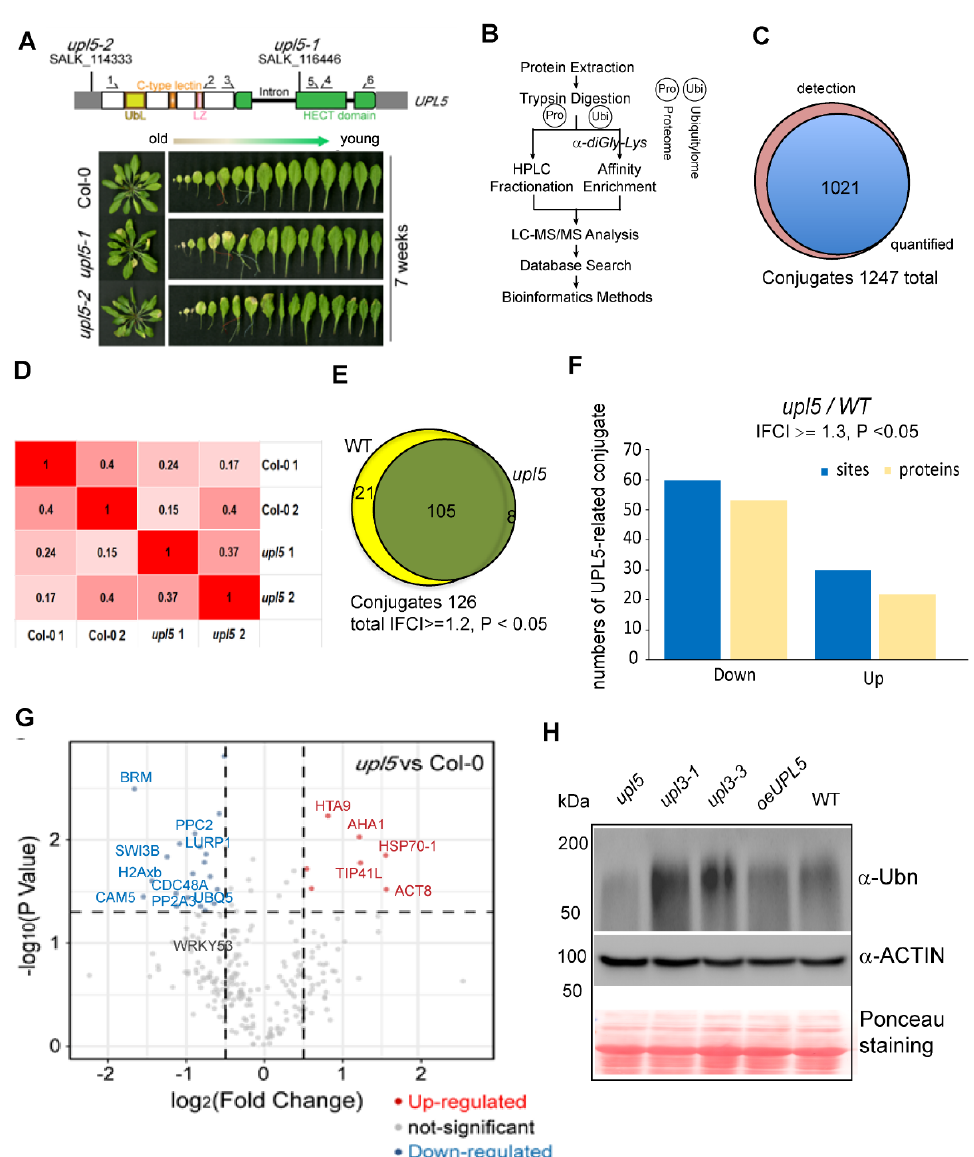
Figure 1. Identification of ubiquitin conjugates in 6-week-old upl5 plants compared to the wild-type (WT). ( A ) Seven-week-old rosette leaves of UPL5 gene T-DNA insertion knockout lines. ( B ) A label-free mass spectrometry-based analysis procedure of protein ubiquitination using K-epsilon-GG remnant antibody enrichment approach. ( C ) Venn diagrams showing the enrichment of differentially ubiquitinated proteins in the upl5 background. ( D ) Pearson coefficient analysis of two replicate samples of the upl5 and the wild-type. ( E ) Venn diagrams showing the enrichment of differentially ubiquitinated proteins (lCFl ≥ 1.2, p value < 0.05) in the upl5 relative to the WT. ( F ) Distribution of enriched proteins and sites within differential fold-change levels (lCFl ≥ 1.3, p value < 0.05) by the upl5 relative to the WT. ( G ) Volcano plot of individual ubiquitination site showing their p value and the log 2 FC. Dark-grey points are conjugates considered to be “abundant” by their detection in two biological replicates and three technique repeats in either background of the upl5 and/or the WT. Proteins with a significant decrease or increase in ubiquitination in the upl5 compared with the WT ( p value < 0.05) are highlighted in red and blue, respectively. Ubiquitinated targets identified in all WT biological replicates and never or only once in upl5 mutants, but that were above the significance threshold of p value > 0.05, are in grey. The dashed line represents the theoretical situation, where conjugate abundance in the WT and the upl5 is equal. The horizontal dashed line highlights a p value = 0.05. The vertical dashed lines highlight a 1.2-fold (log 2 FC = 0.26) increase or decrease. ( H ) Immu- nodetection of global ubiquitinated proteins in WT plants and loss of or gain of UPL5 mutants using